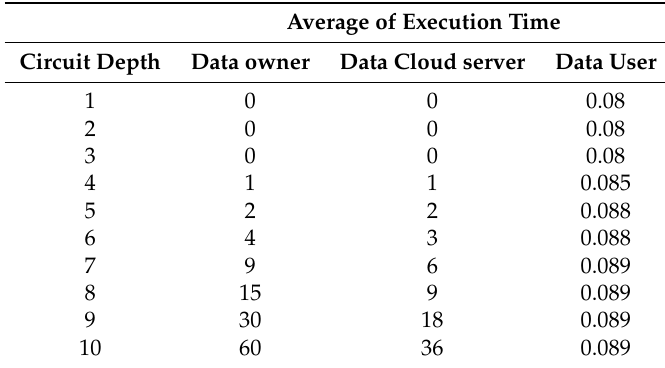
Table 1. Data owner depth circuit execution time